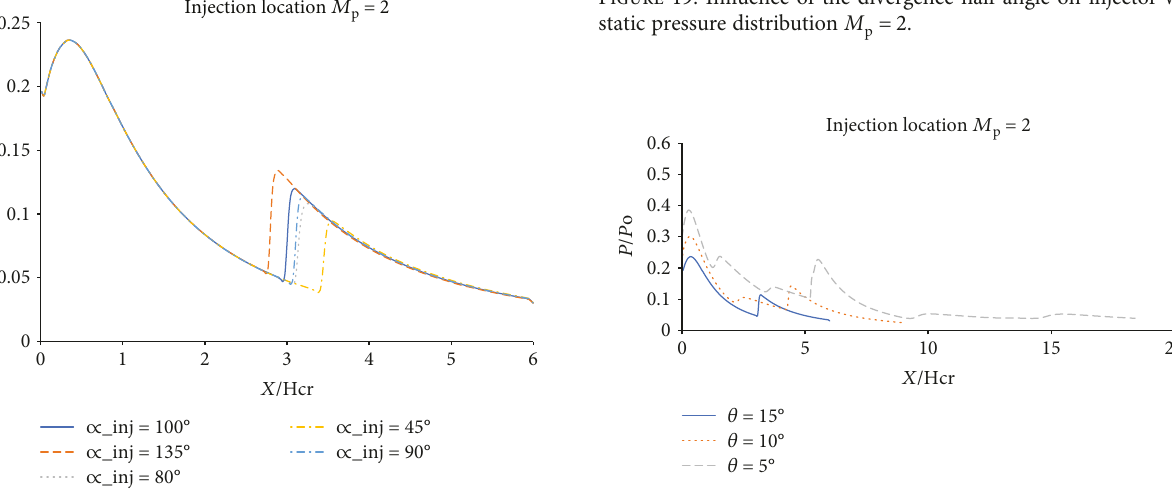
Figure 20: In fl uence of the divergence half angle on lower wall static = 2 pressure distribution M p